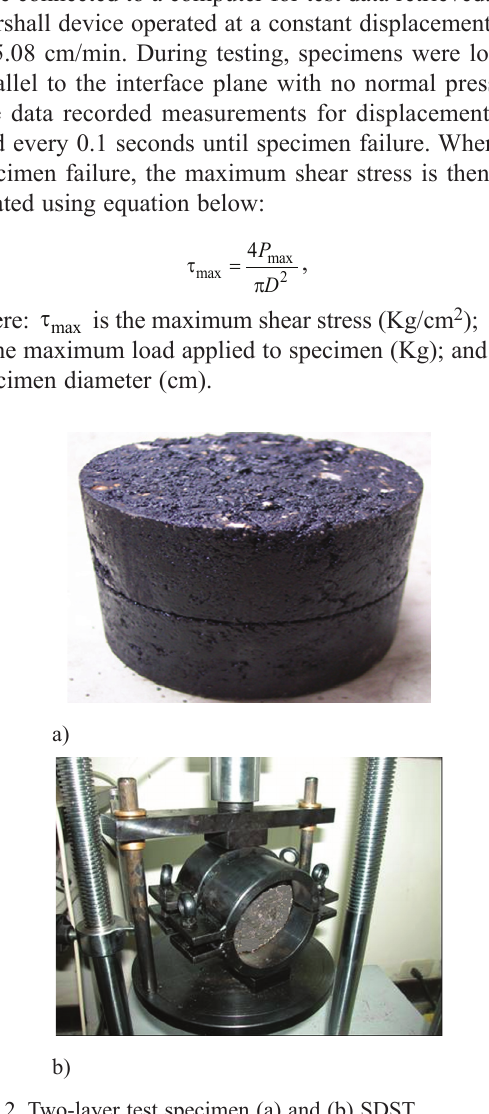
Fig. 2. Two-layer test specimen (a) and (b)